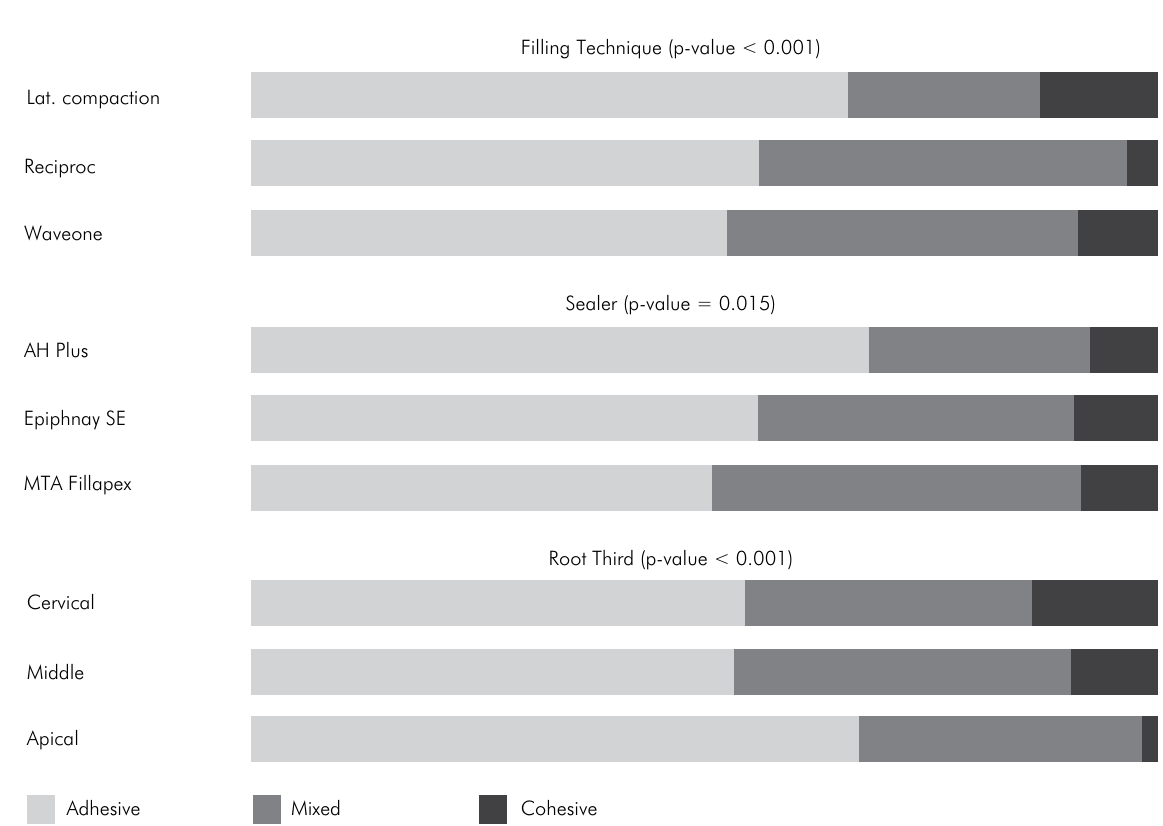
Figure 3. Results for analysis of failure modes. The p-value was obtained from the chi-square test.